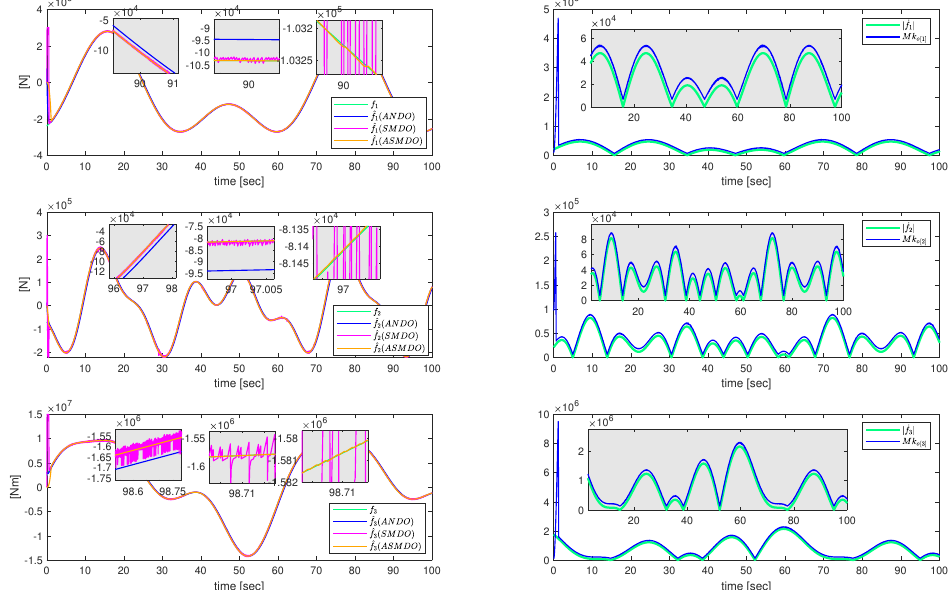
Figure 3. Disturbance estimation and double-layer adaptive switching gain (continuous